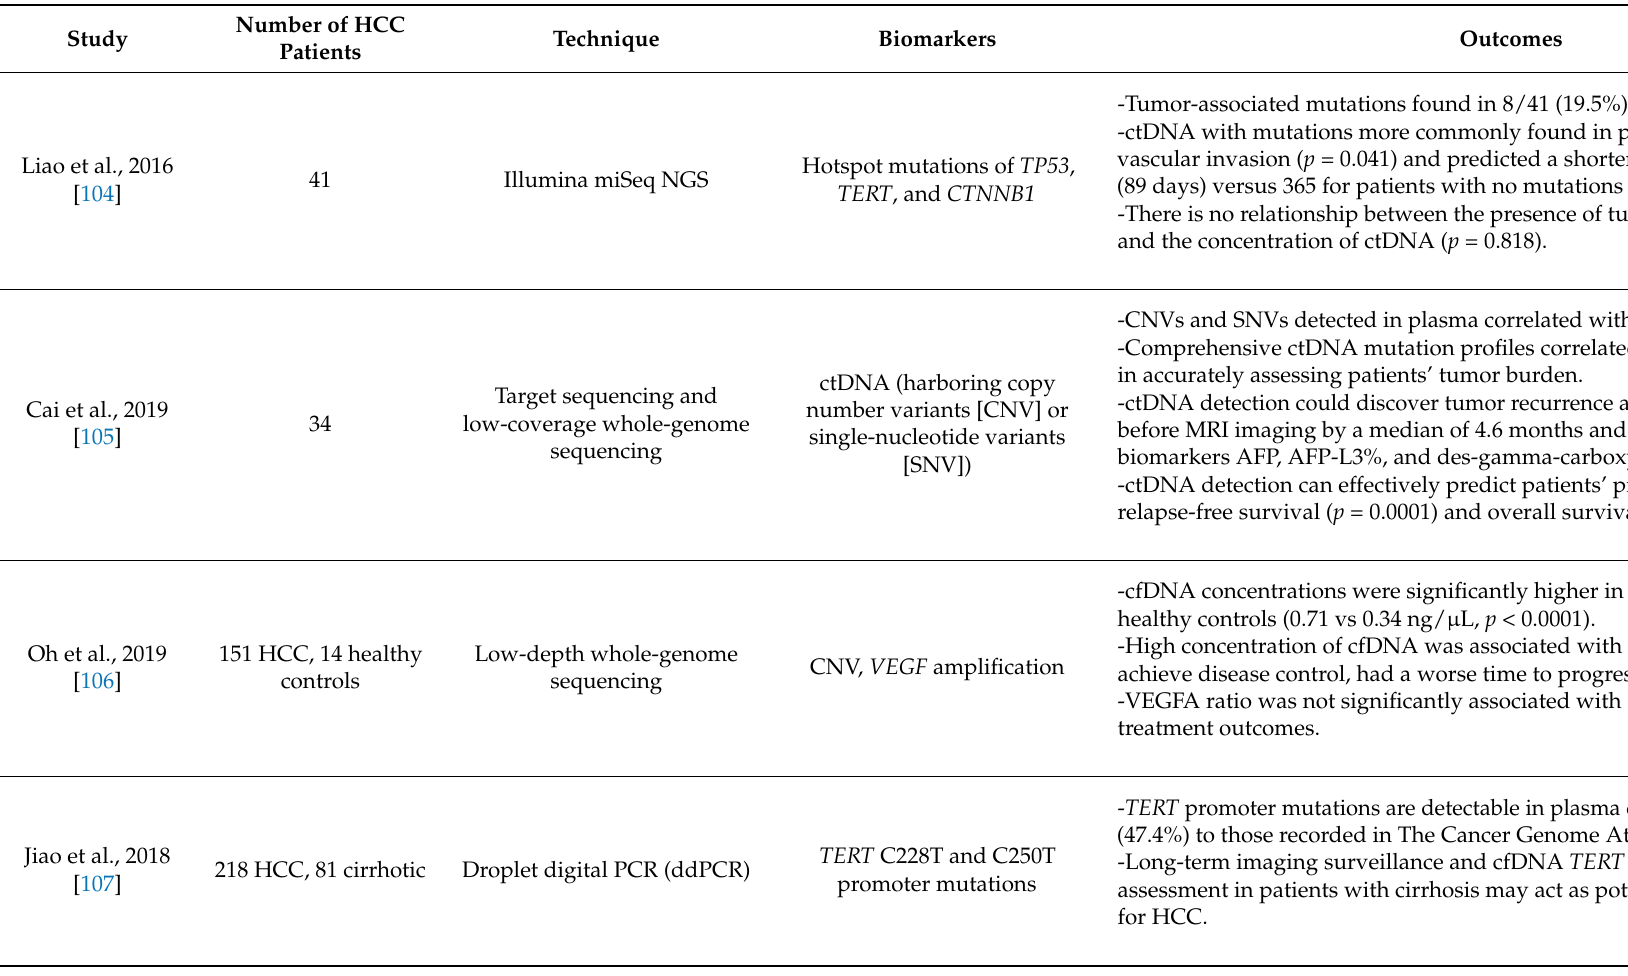
Table 1. Circulating tumor DNA studies in HCC and transplantation cases to evaluate minimal residual disease, cancer recurrence, and transplant rejection.